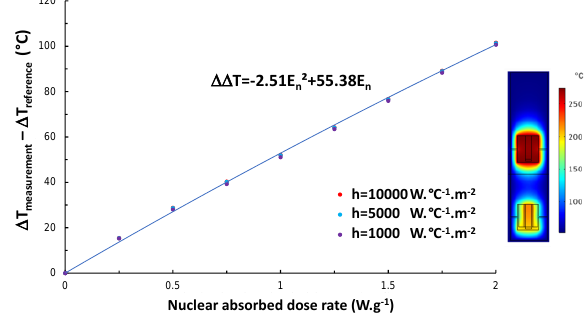
Fig. 5. 3-D numerical responses of the new design of CALORRE calorimeter for three values of the external heat transfer coefficient (on the left-hand section) and the temperature field for a nuclear absorbed dose rate equal to 2 W.g -1 (h=10000 W.°C -1 .m -2 and T f =50 °C) (on the right- hand